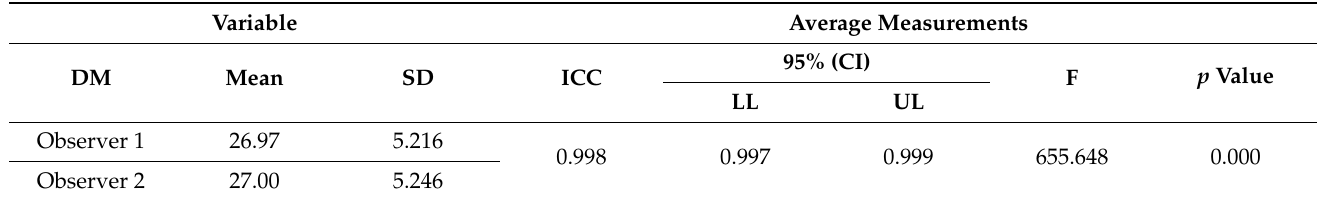
Table 7. Values in the ICC in the interobserver assessment of Direction of Movement (DM) and average